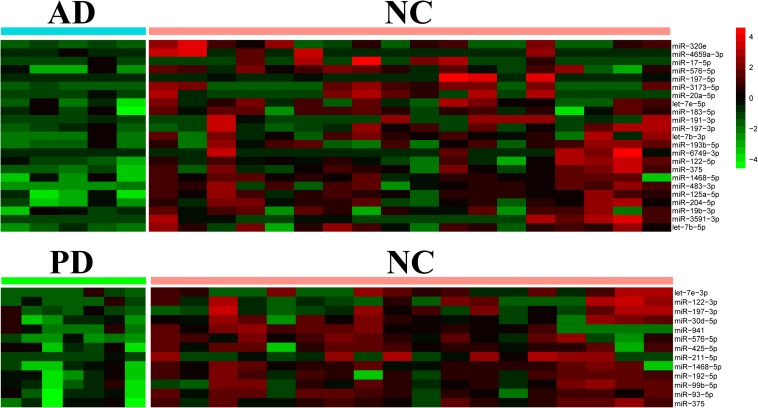
Heatmap of differential expression levels of miRNAs in AD and PD patients. The color scale shown on the right illustrates the expression level (log2) of a miRNA across all samples. Each row represents significantly declined miRNAs (p < 0.05) in AD or PD patients including 23 declined miRNAs in AD patients and 13 declined miRNAs in PD patients.